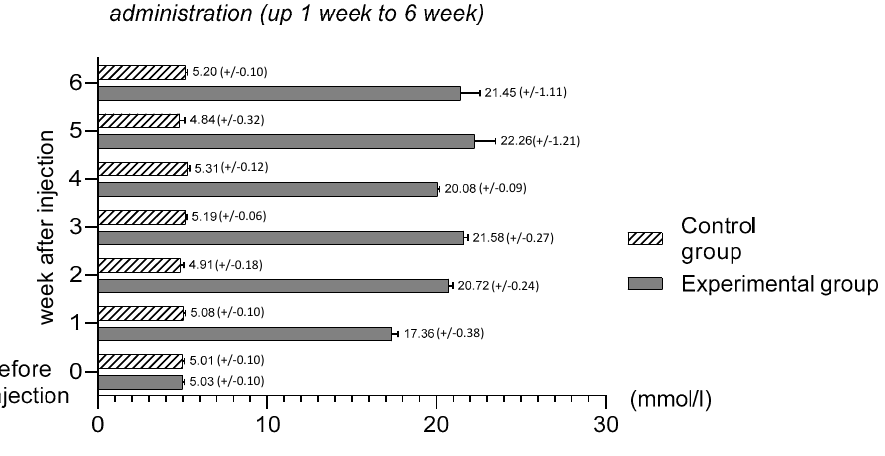
Figure 1. Serum glucose concentration before induction of diabetes and glucose accumulation after streptozotocin injection (up 1 week to 6 weeks).